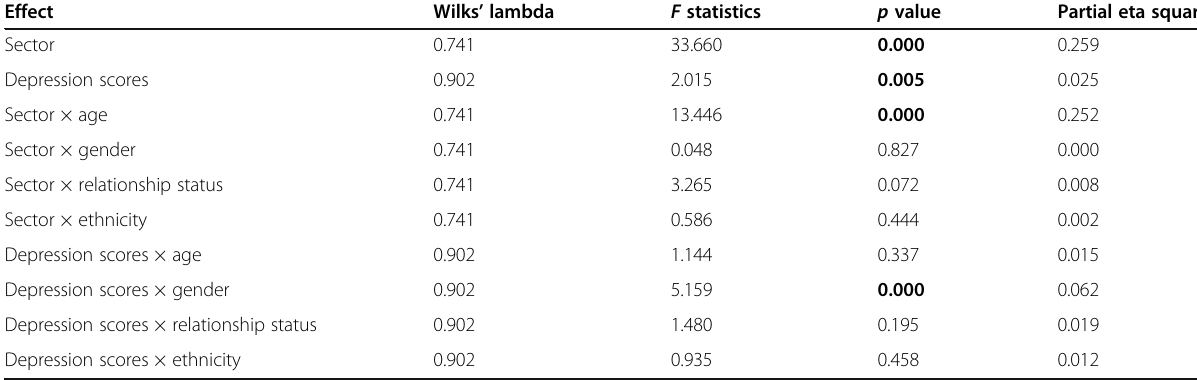
Table 1 Association of sector and depression scores on demographic variables Effect